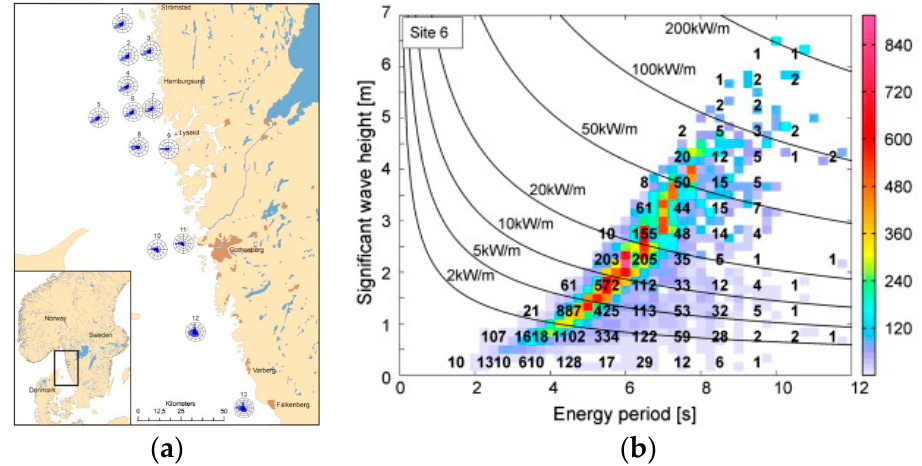
Figure 3. Map and sea states at the test Site 6 studied by the Lysekil Project: ( a ) map presenting the location of the studied sites. The wave roses are placed with their center on the studied sites and show the distribution in time of the direction on incoming waves; and ( b ) combined scatter and energy diagrams for Site 6. Colors show annual energy transport per meter of wave front (kWh/year). Numbers give average occurrence in hours per year. These two figures are cited from a published research article [20].